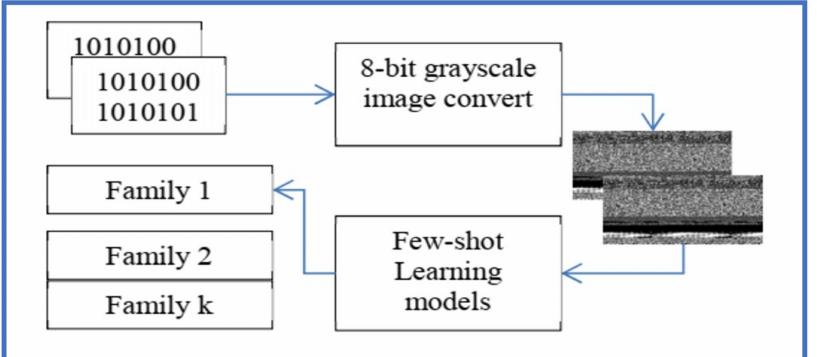
Figure 10. Proposed Approach in